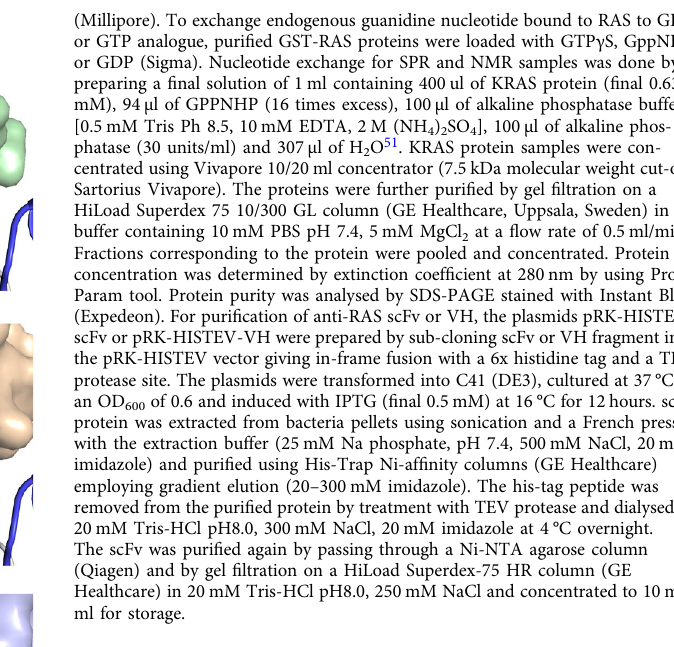
above 300 Da. Each compound was dissolved at 200mM in 100% DMSO and 41 compounds were removed from the library because of insolubility in DMSO i.e. from the library, 615 useful compounds could be screened at the concentrations used. The library was replica plated (20 mM concentration) and stored at − 80°C. The initial hit compound (Maybridge) was N -(2-quinolinyl)-2-furamide (C 14 H 10 N 2 O 2 ), product code HTS05481, MW:238.2456, clogP 2.33, Rotatable bonds: 2, H-bonds donor: 1, H-bonds acceptor 4.